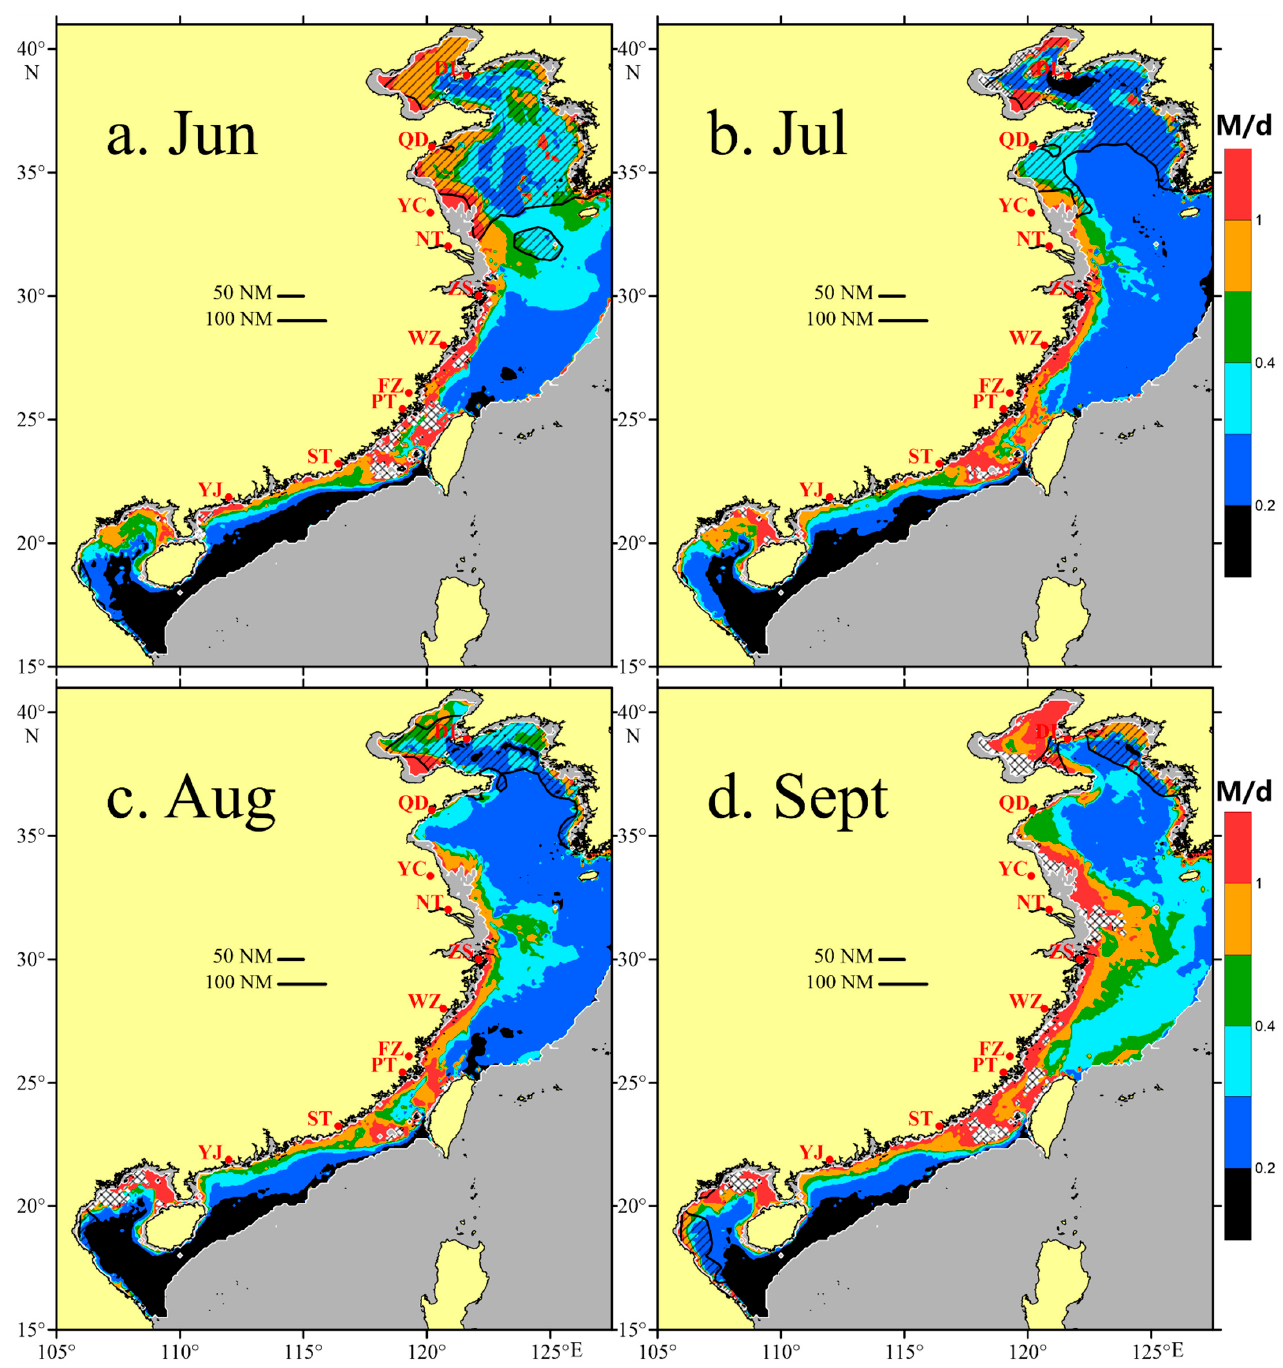
Figure 8. Distribution of the maximum seawater vertical velocity (M/d) in the waters adjacent to China. The two horizonal black bars indicate reference lengths of 50 NM and 100 NM, respectively. The regions covered by slashes are of wind speed less than 5 m/s. The crosshatching indicates the regions without stratification.